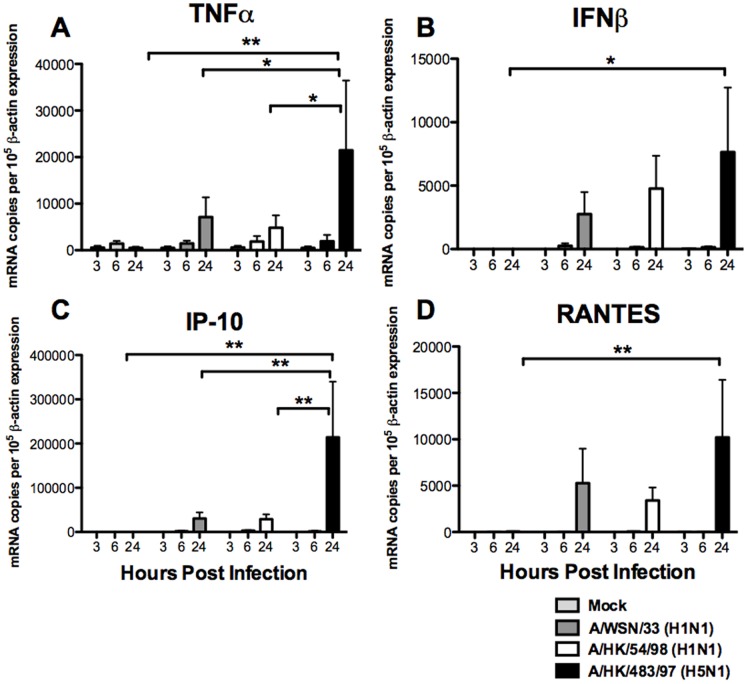
Cytokine and chemokine gene expression in mouse bone marrow derived macrophages after influenza A virus infection.The cytokines (A) TNF-α, (B) IFN-β, (C) IP-10 (CXCL-10) and (D) RANTES (CCL-5) mRNA gene expression profile of influenza-virus-infected mouse bone marrow derived macrophages were analyzed by quantitative RT-PCR. The graph shows the mean and the standard error from three independent experiments. Single and double asterisks indicate statistically significant difference with p<0.05 and p<0.01 respectively.